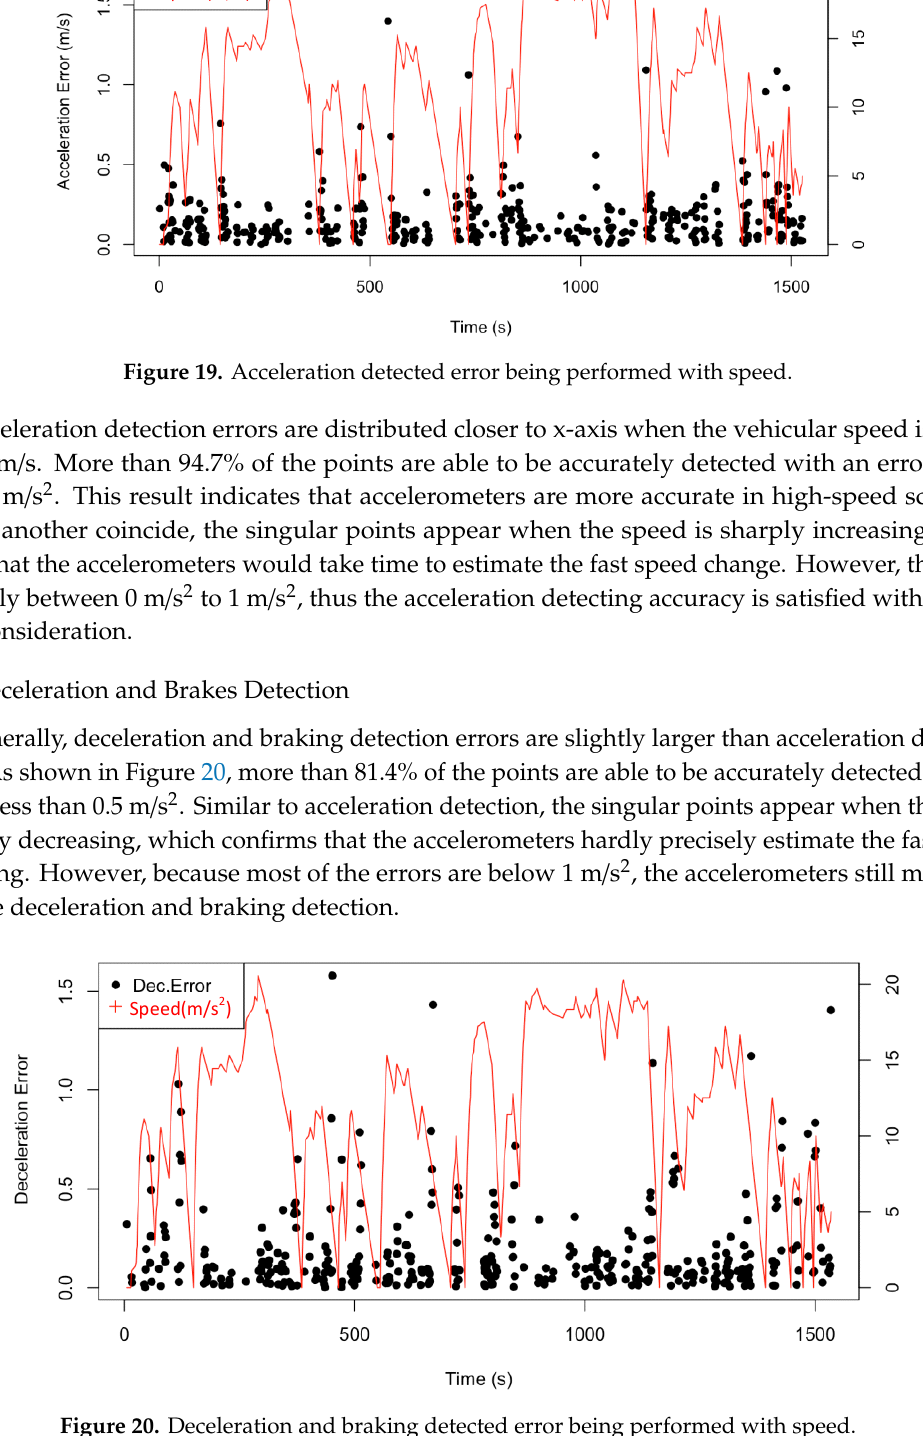
Figure 21. Relative position detection of different roads. 4.4. Driving Safety and Distraction Wi-Fi direct is used to transmit self-driving status to other vehicles. In this study, small-scale tests are conducted using simulator vehicles. Several patterns of voice alerts, like front car lane- changing, back car accelerating, front car turning to warn, and so on, are given to participants when they operate the simulator vehicles. Drivers’ behavior and operational changing are recorded with the assistance of VMDS. In addition, fixation duration and pupil size during trips are applied as the